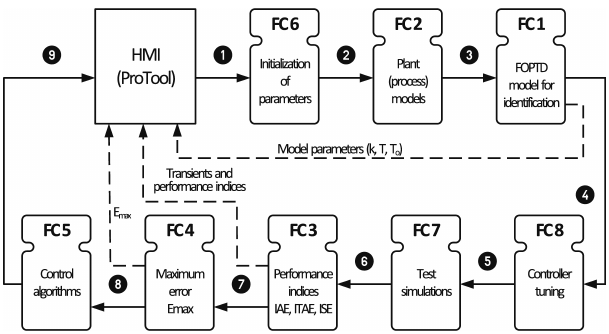
Figure 5: The controller selection